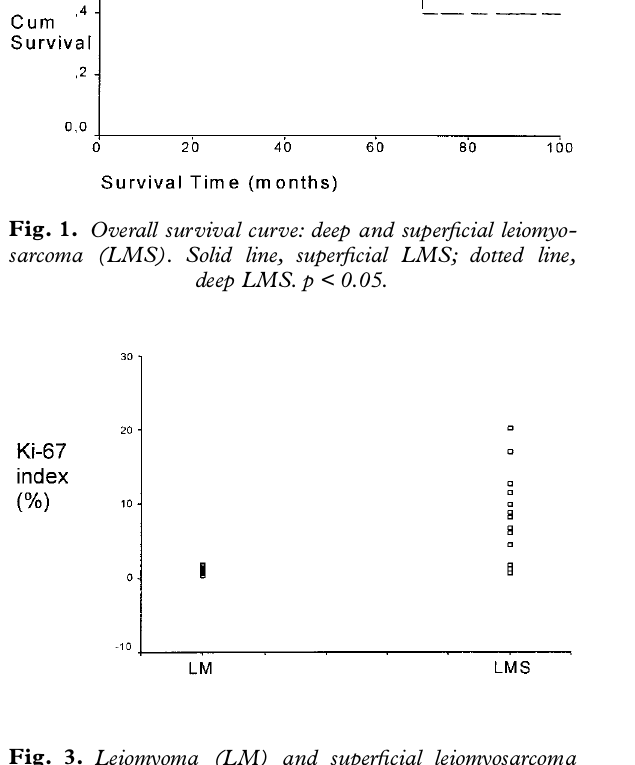
Fig. 3. Leiomyoma (LM) and super(cid:142) cial leiomyosarcoma (LMS): Ki-67 indices. p < 0.005.